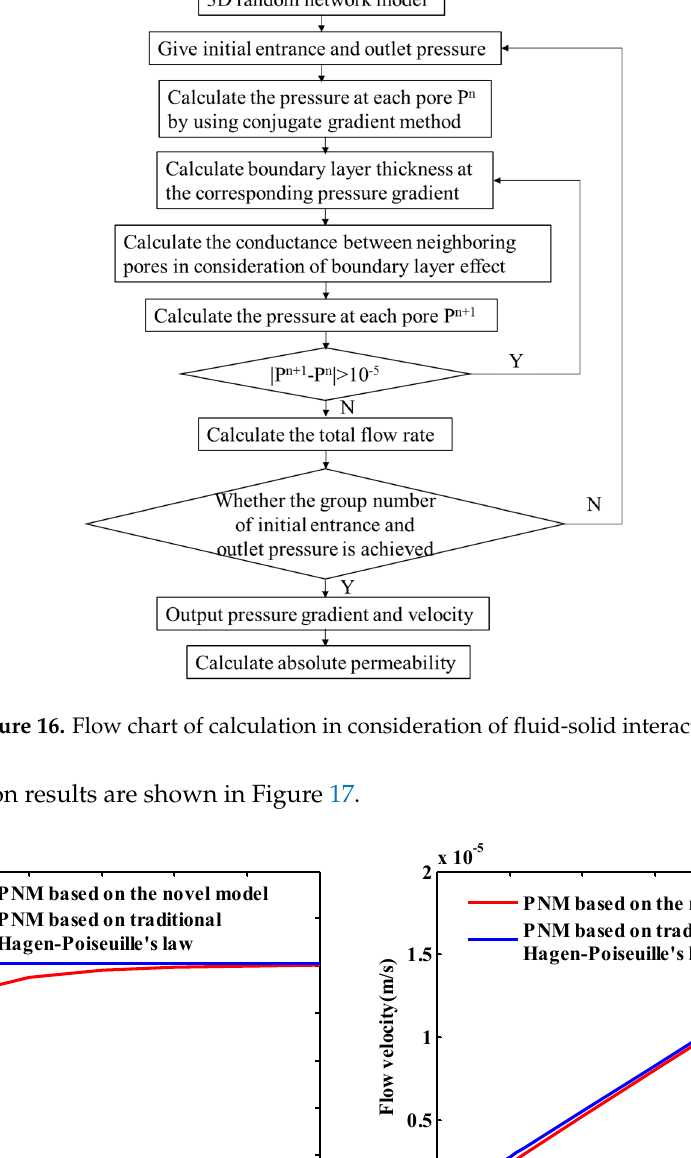
Figure 15. Scheme of pore network model (red part represents boundary layer while blue part represents the effective flow space): ( a ) Flow through every pore; ( b ) Conductance between two neighboring pores.